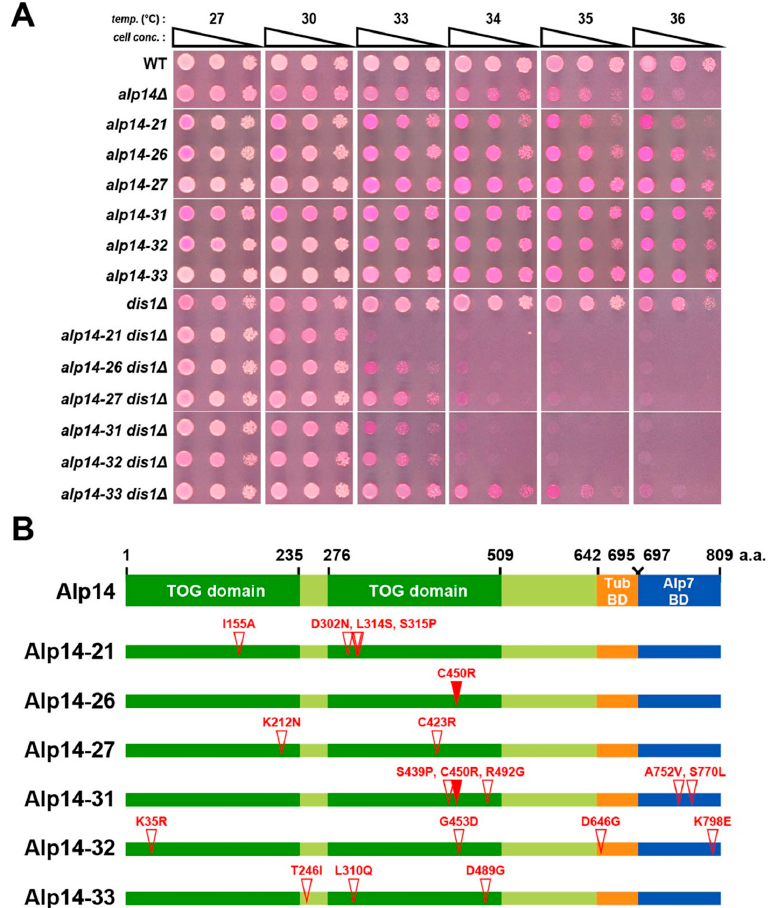
Figure 1. Isolation of alp14 temperature-sensitive mutations in the dis1 ∆ background. ( A ) Spot test. Indicated strains were serially (10-fold) diluted, spotted onto rich YE5S plates containing Phloxine B and incubated at the indicated temperatures for 2–3 d. ( B ) Mutation sites in the alp14 mutants. Mutated amino acid residues are shown with open triangles. Note that the C450R mutation was found in both alp14-26 and alp14-31 (shown with closed triangles).